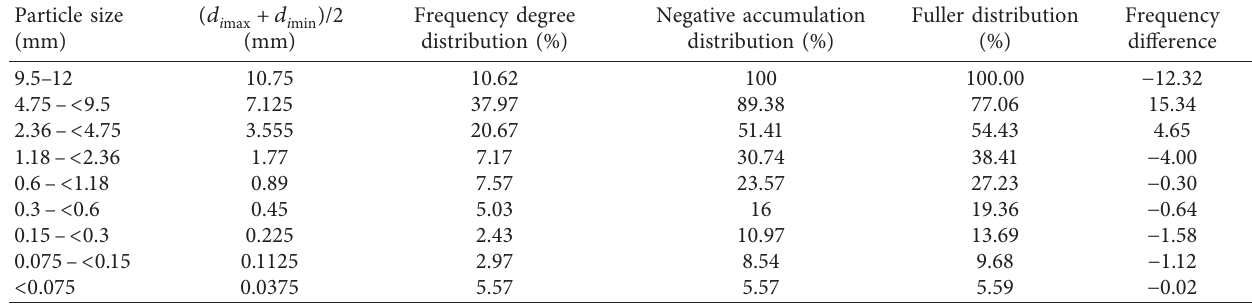
Table 4: Gradation of waste rock.